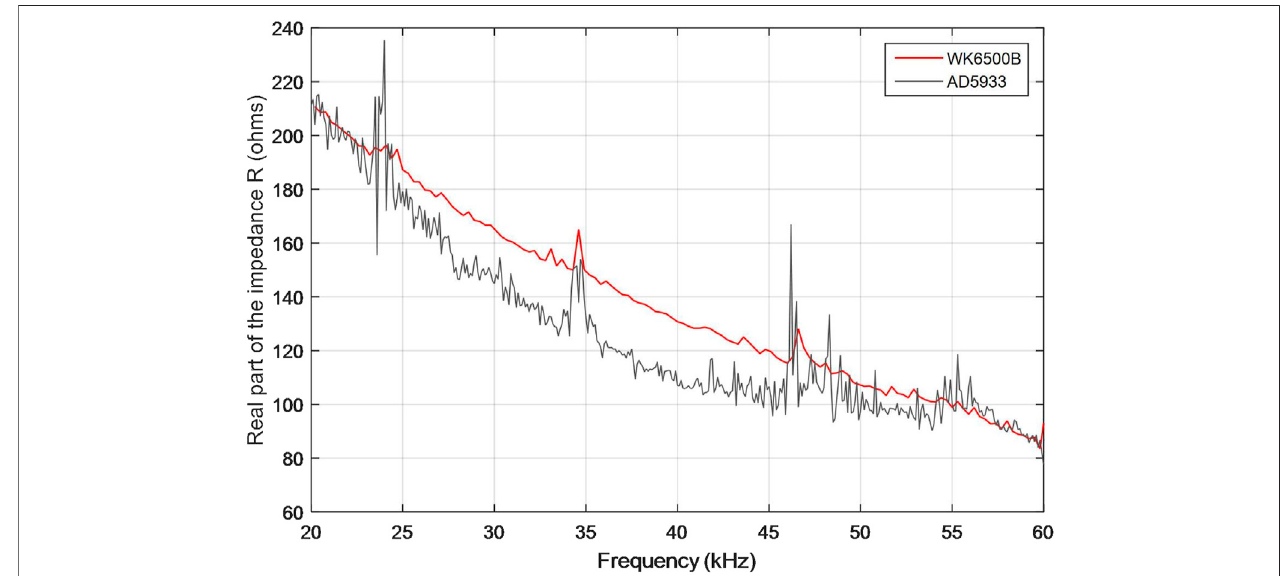
FIGURE 5 | Comparison of impedance from WK6500 and AD5933 for the pipeline specimen.